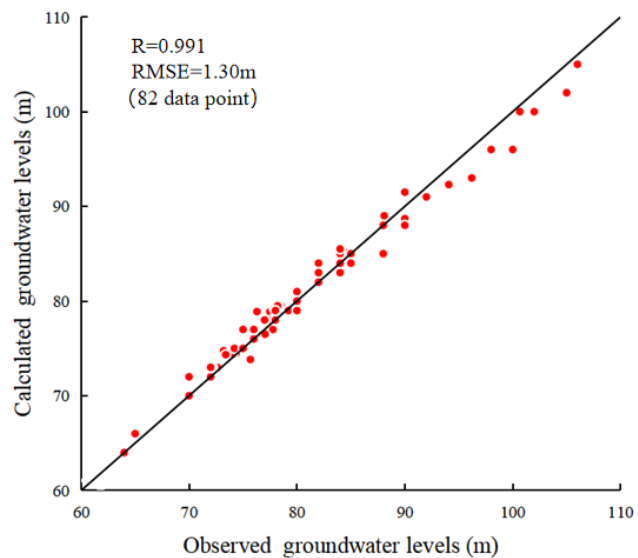
Figure 8. Scatter plot for observed groundwater level vs. simulated groundwater level.